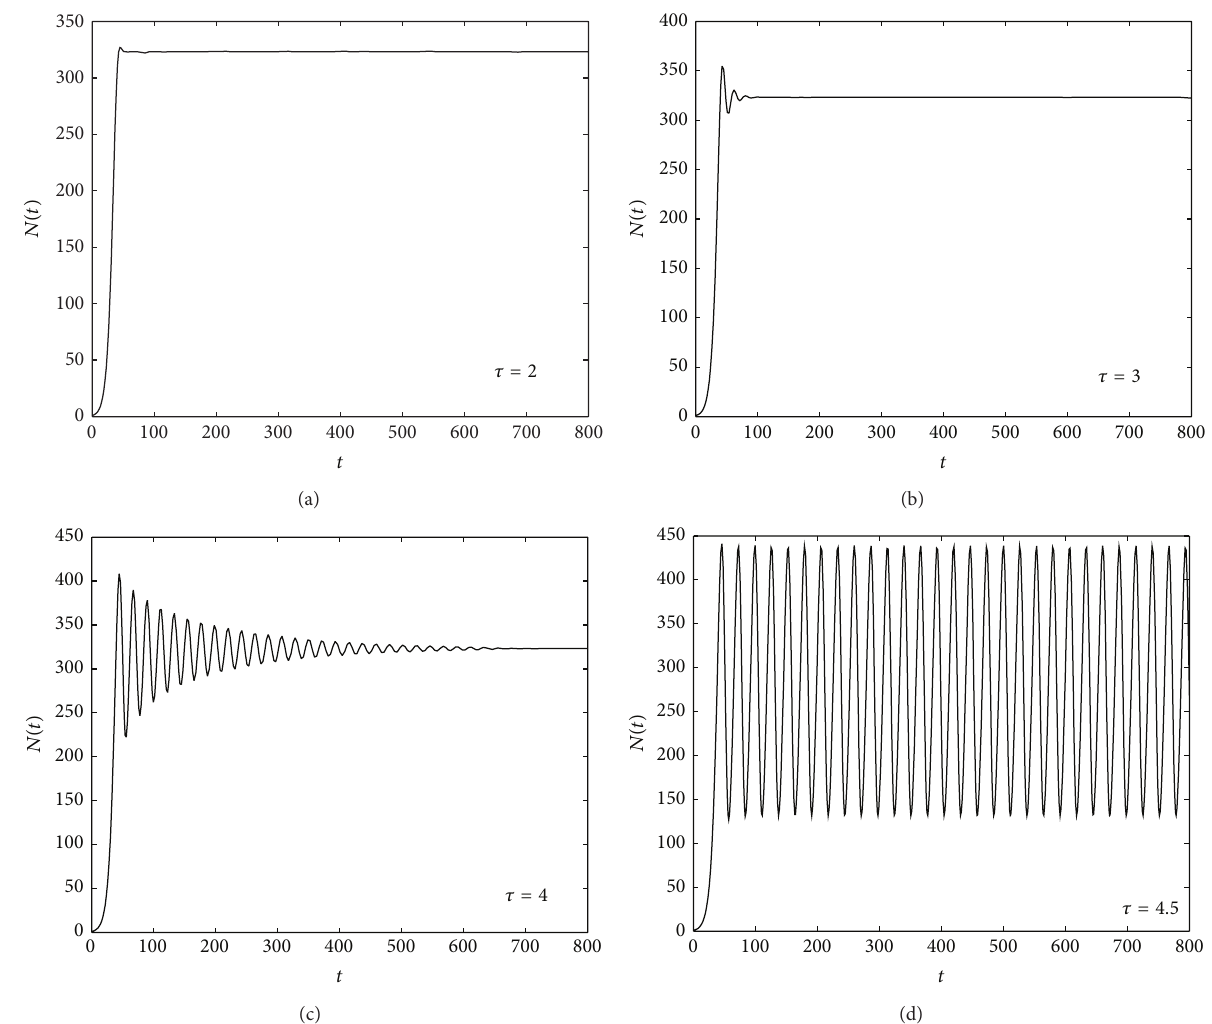
Figure 1: Time process diagrams of credit risk contagion in the financial market under the influence of time-delay 𝜏 .